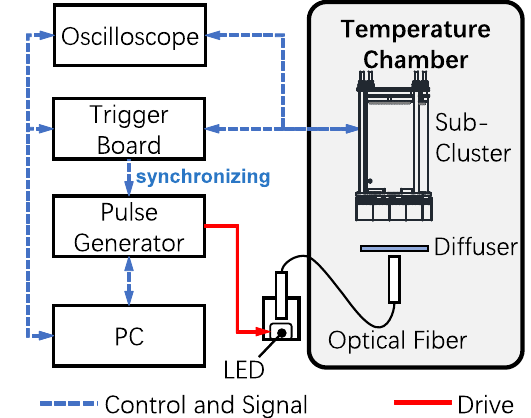
Fig. 9 TheschemeofTemp-System.Theroundedrectanglerepresents the temperature chamber, which is utilized to provide the temperature environment required for tests. The boxes represent the data acquisition and the control